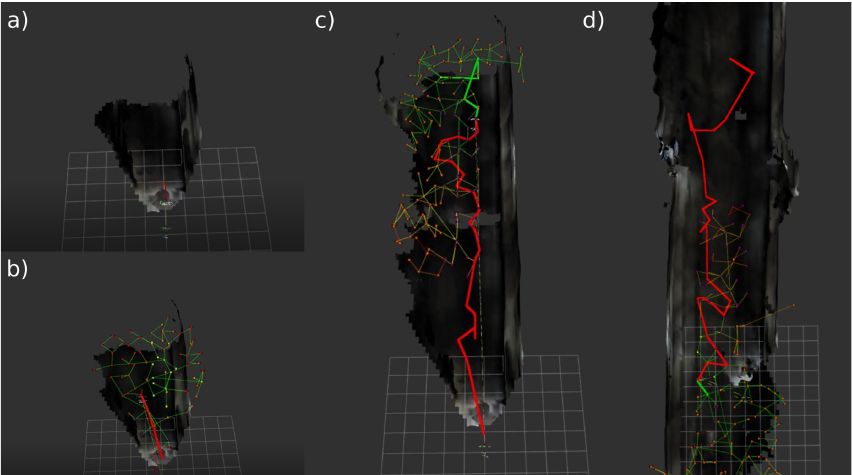
Figure 10. Instances of an autonomous inspection trajectory performed by the aerial vehicle: ( a ) Real- time map generation at take-off. ( b ) Environment sampling and movement to the first next-best-view location. The robot’s trajectory is marked in red. ( c ) Inspection trajectory following the tunnel wall while keeping a safe distance. ( d ) Return to take-off trajectory while inspecting the opposite